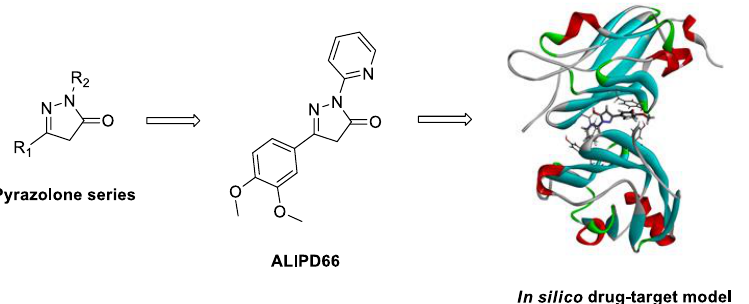
Figure 31. Example of one of the lead molecules of the pyrazolone series and its in silico drug-target model.